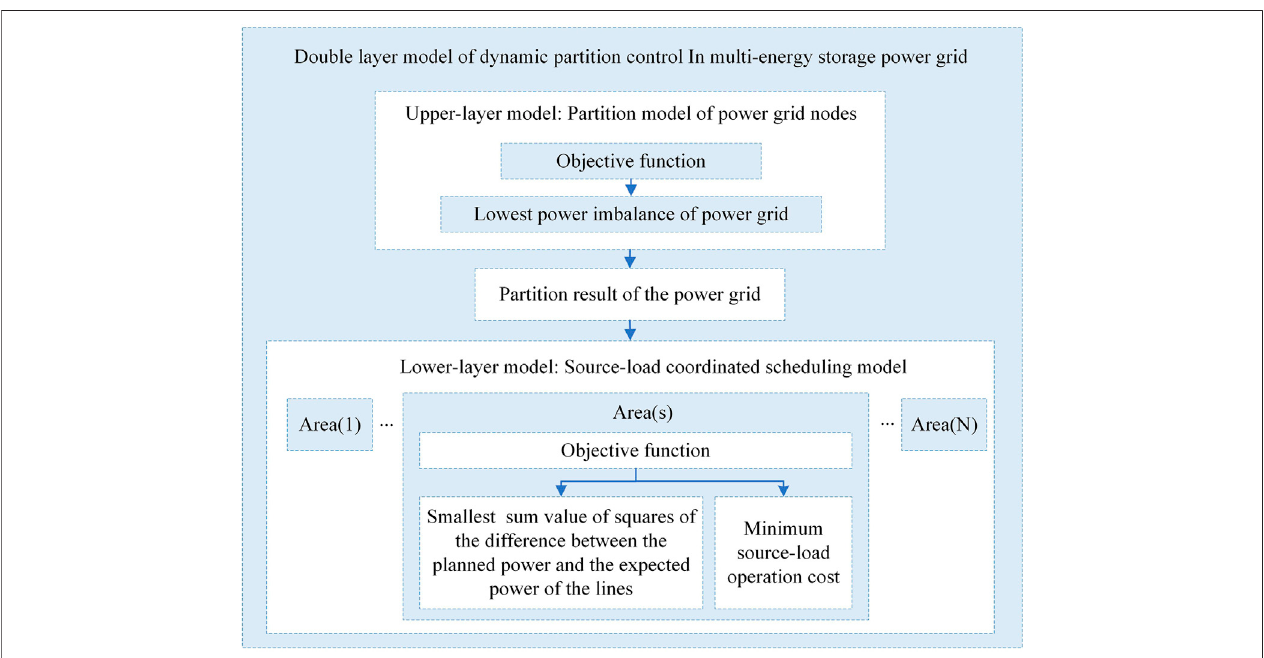
FIGURE 1 | Double-layer model structure diagram of power grid partition